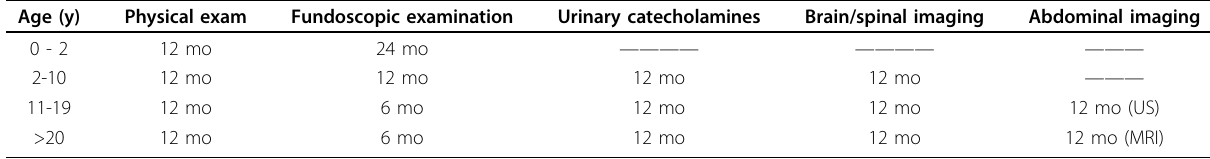
Table 1 Tumor surveillance program in VHL gene mutation-carriers Age (y) Physical